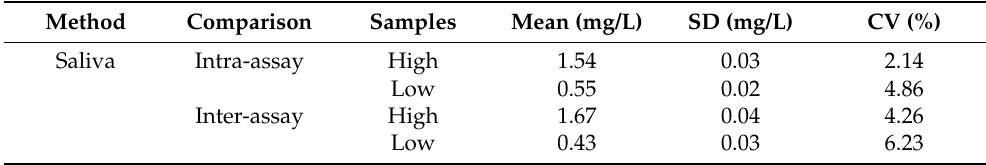
Table 1. Precision study of the salivary calprotectin assays. (SD, standard deviation; CV, coefficient of variation).